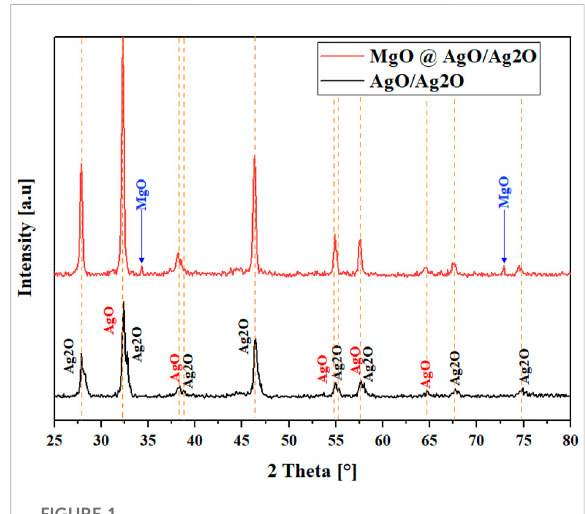
FIGURE 1 XRD patterns of AgO/Ag 2 O and MgO@AgO/Ag 2 O